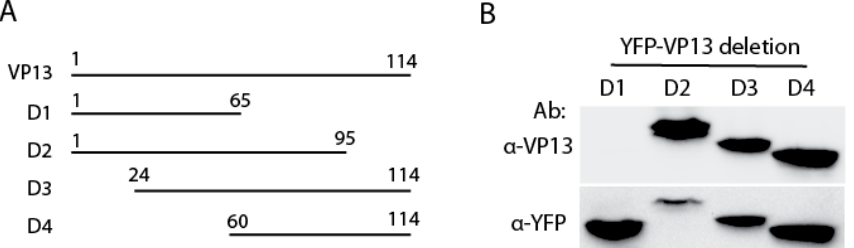
Figure 2. The region of amino acid 66–95 of VP13 specifically reacts with the Mab. ( A ) Illustration of VP13 and truncation mutants. D1, D2, D3 and D4 indicate VP13 deletion constructs. The numbers above lines indicate positions of amino acids in VP13; ( B ) WB of VP13 truncation mutants with the Mab. HEK293 cells were transfected with YFP-VP13 plasmids of the four VP13 truncation fragments. Ab: antibody